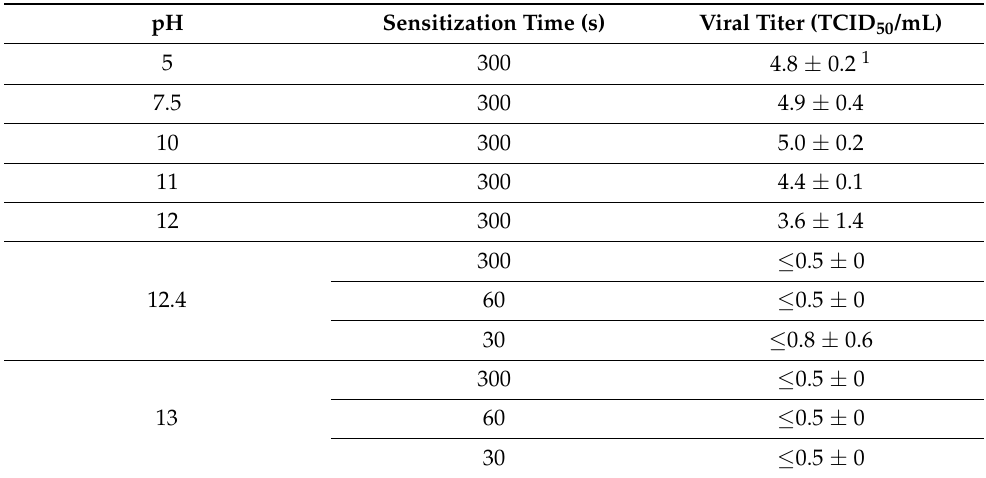
Table 3. Effect of pH on virus activity.